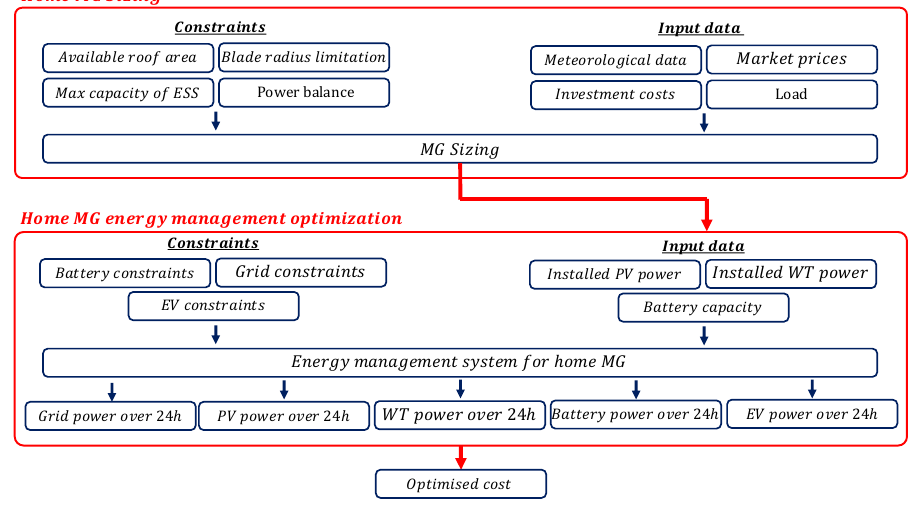
Figure 2. Scheme describing the proposed MG sizing and energy management